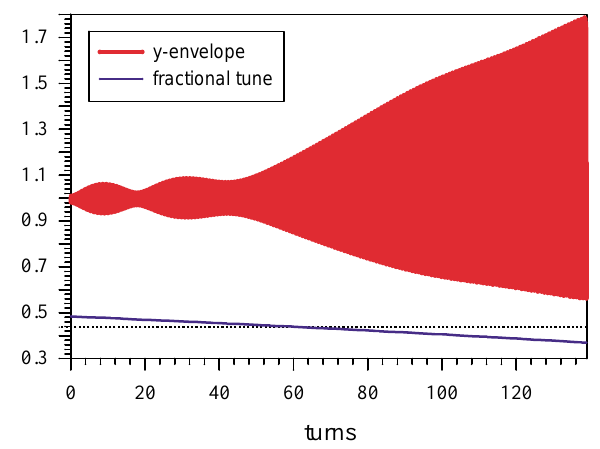
Fig. 18. Fourier analysis of the vertical beam envelope